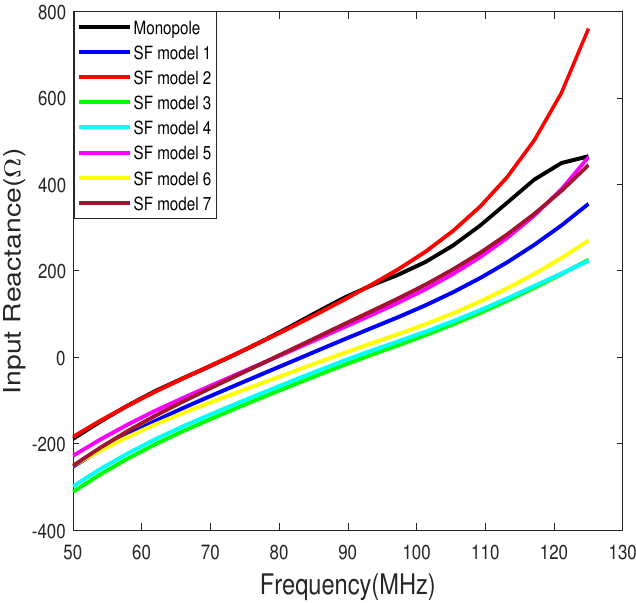
Figure 21. Input reactance of the monopole and the single-fold antenna models from